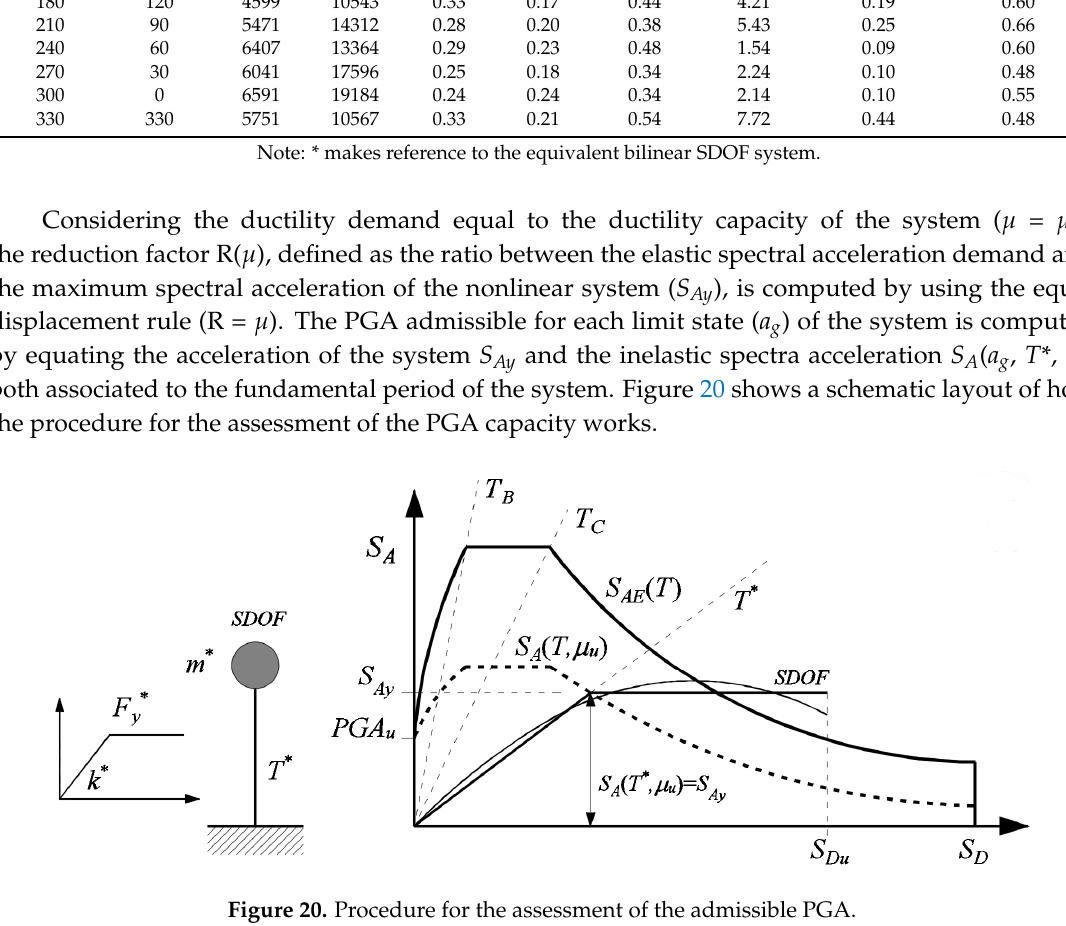
Figure 20. Procedure for the assessment of the admissible PGA.